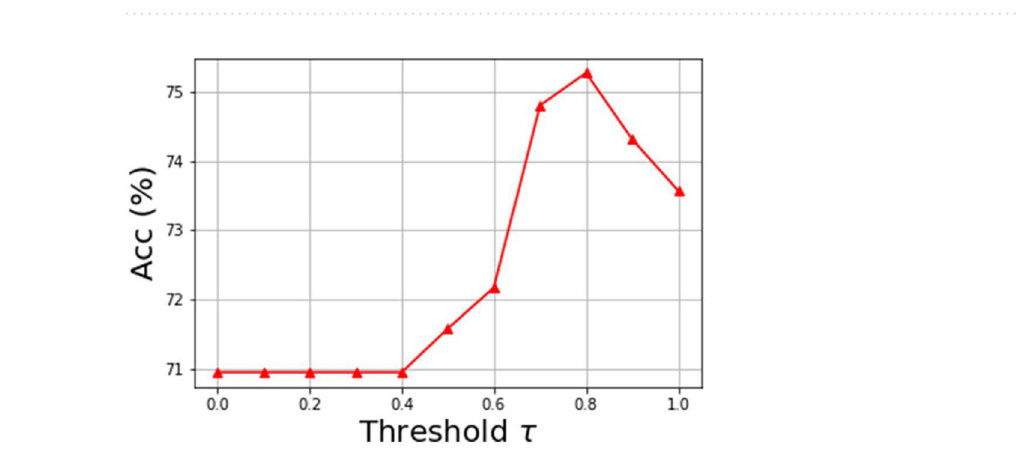
Figure 5. The performance with respect to different thresholds τ . The accuracy is used as the metric for selecting the best τ